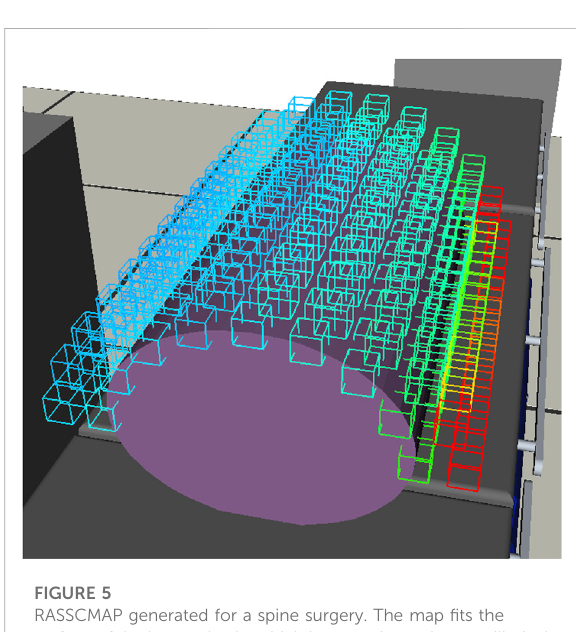
FIGURE 5 RASSCMAP generated for a spine surgery. The map fi ts the surface of the human body, which is approximated as an elliptical